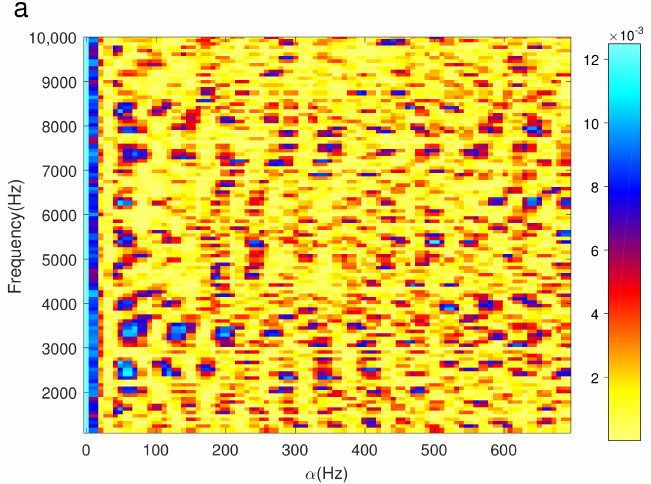
Figure 7. The MID SCoh ∆ of the original simulated vibration signal (the noise variance is f